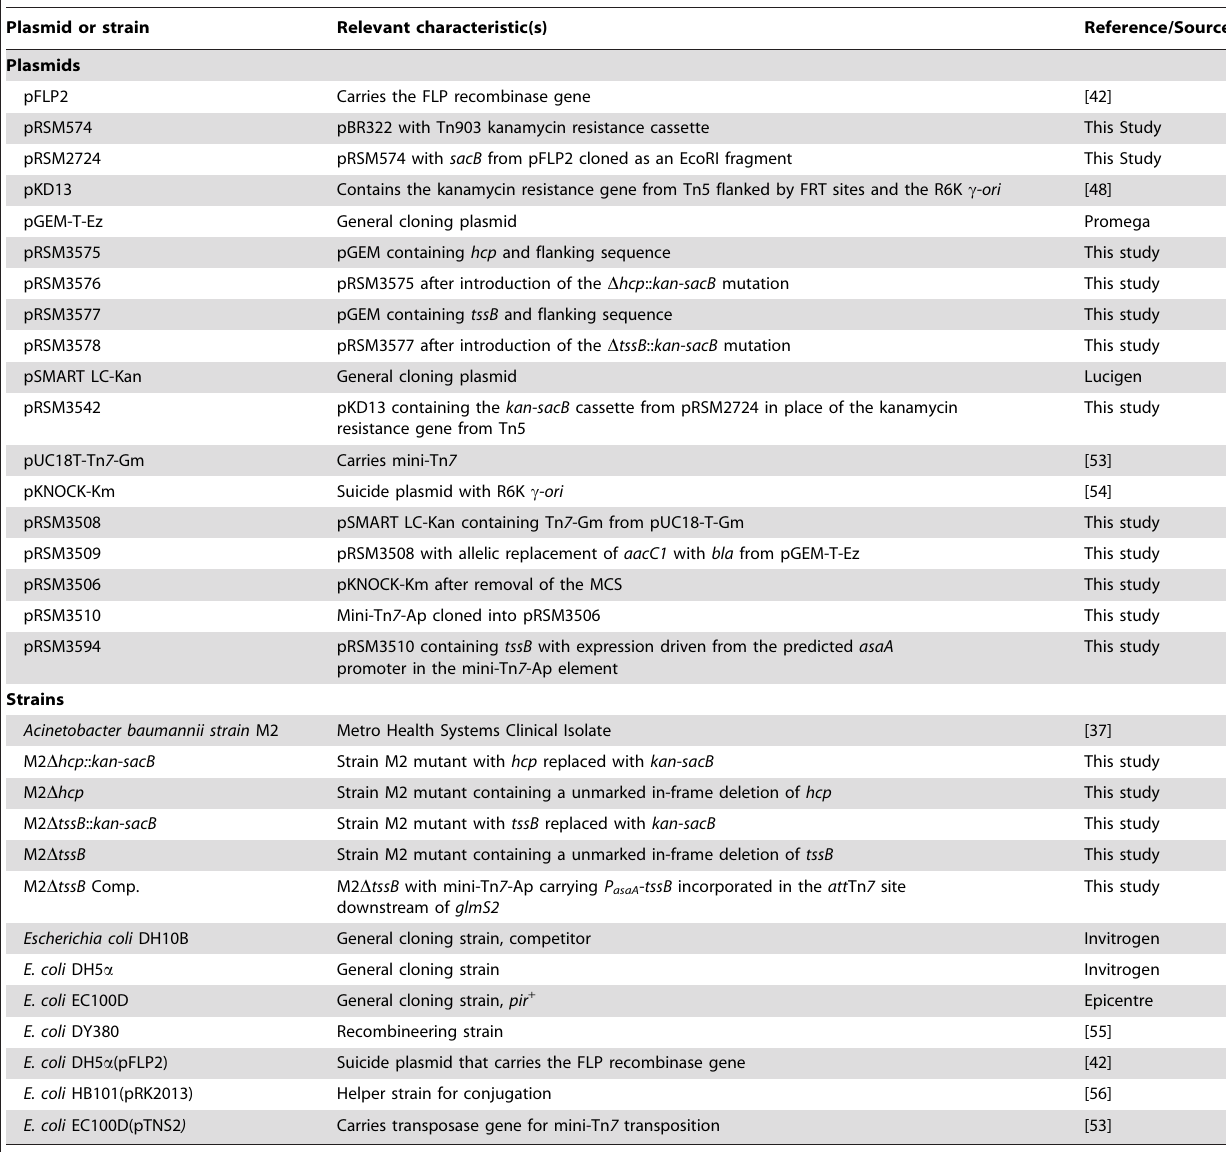
Table 1. Plasmids and bacterial strains included in the study.